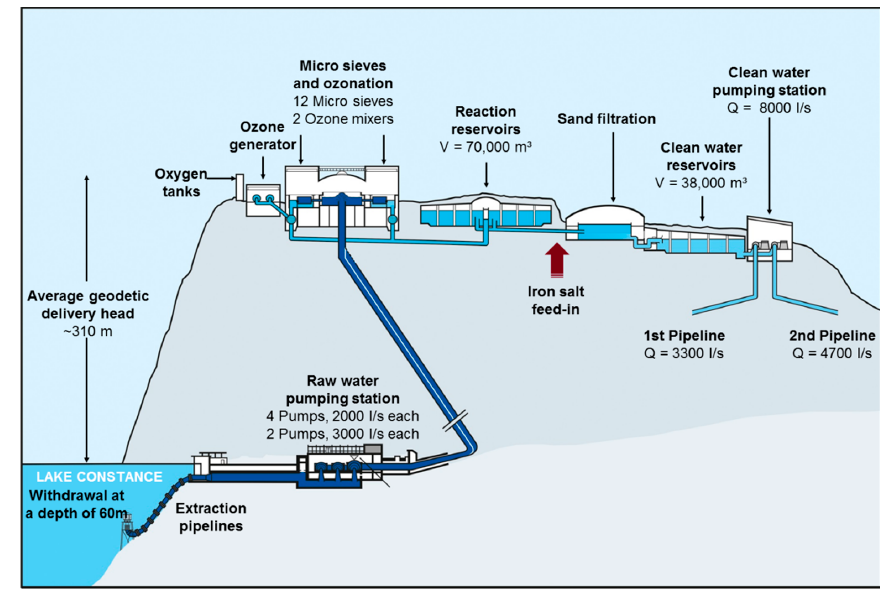
Figure 1. Zweckverband Bodensee-Wasserversorgung (BWV) water pumping and treatment system. Six centrifugal raw water pumps with two power levels with a maximum capacity of 35 MW lift